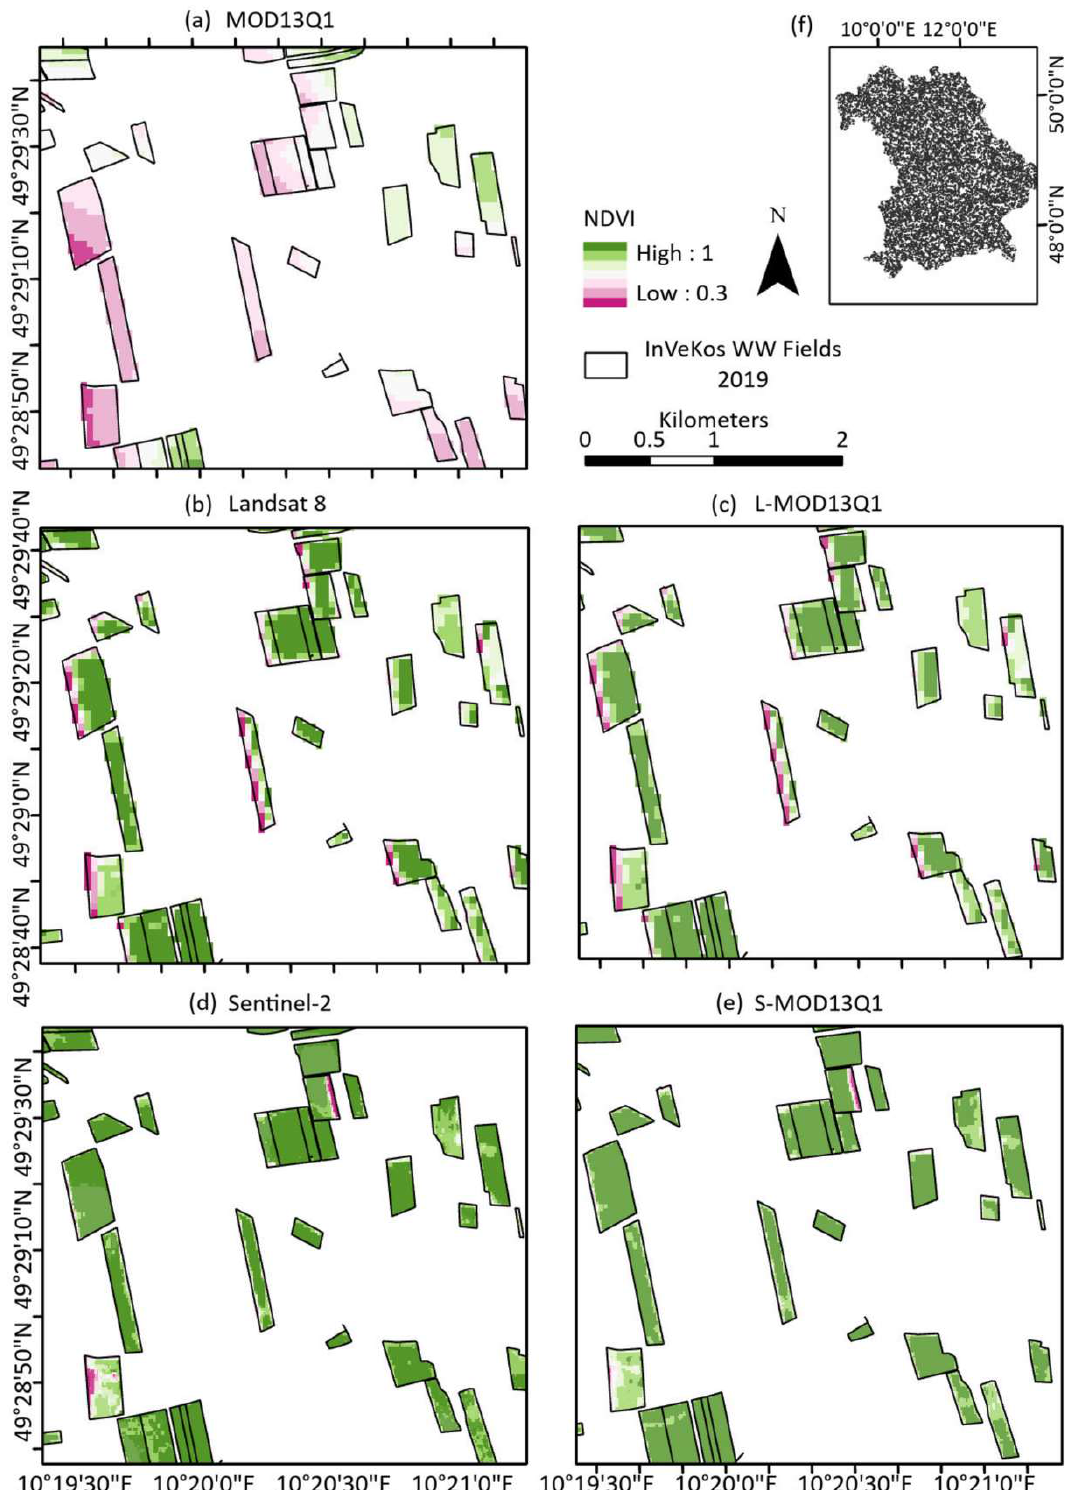
Figure 4. Field-wise comparison of STARFM and real-time NDVI values of ( a ) MOD13Q1, ( b ) Landsat 8, ( c ) L-MOD13Q1, ( d ) Sentinel-2, and ( e ) S-MOD13Q1 on DOY 145 (25 May 2019) on WW fields. The image in ( f ) shows the spatial location of 10,000 random points in Bavaria used to draw line and bar plots in Figure 5 for comparing the mean NDVI values on a DOY basis for the real and synthetic NDVI products.